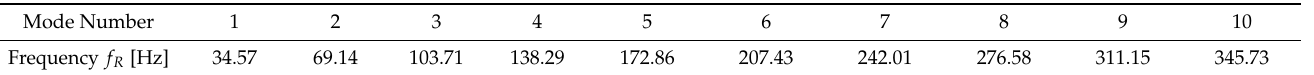
Table 8. Cavity Rossiter modes computed with Equation (24) for γ = 0.25 and K = 0.57.